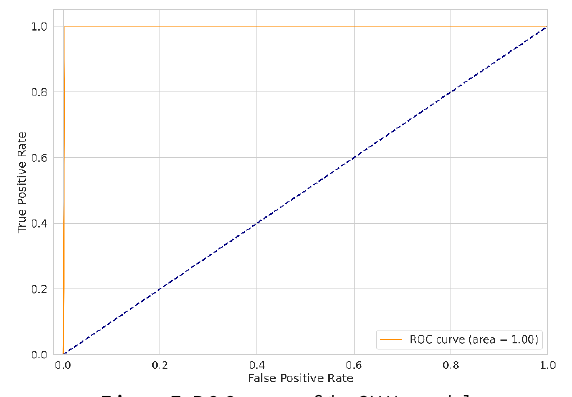
Figure 7 . ROC curve of the SVM